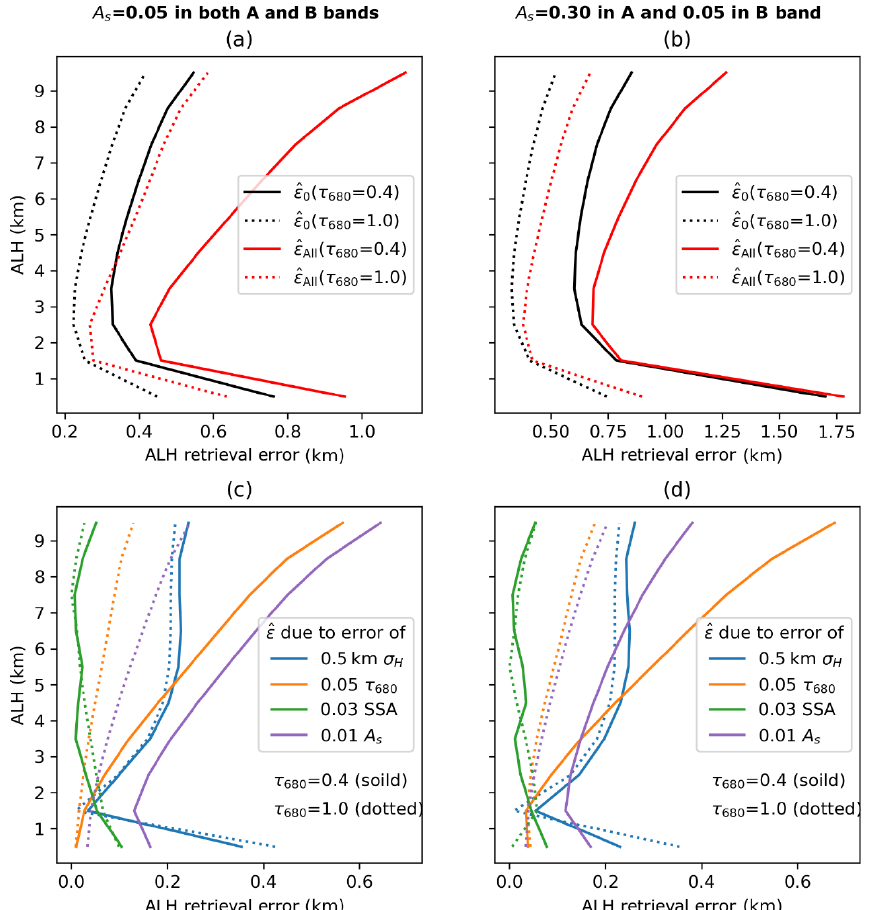
Figure A2. Estimated ALH retrieval errors owing to EPIC measurement errors and uncertainties in aerosol and surface assumptions. Panels (a) and (c) are for a surface with A s = 0 . 05 reflectance in both the O 2 A and B bands (close to a water surface), and panels (b) and (d) are for A s = 0 . 30 in the A band and A s = 0 . 05 in the B band (close to a vegetation surface). (a–b) ALH retrieval errors due to 2% EPIC measurement error alone (black curves) and with model uncertainty from all four parameters added (red curves). (c–d) The error in retrieved ALH due to uncertainty from each of the parameters: 0.5km in σ H (blue), 0.05 in τ 680 (orange), 0.03 in SSA (green), and 0.01 in A s (purple). In all panels, the solid and dotted curves represent 0.4 and 1.0 τ 680 ,